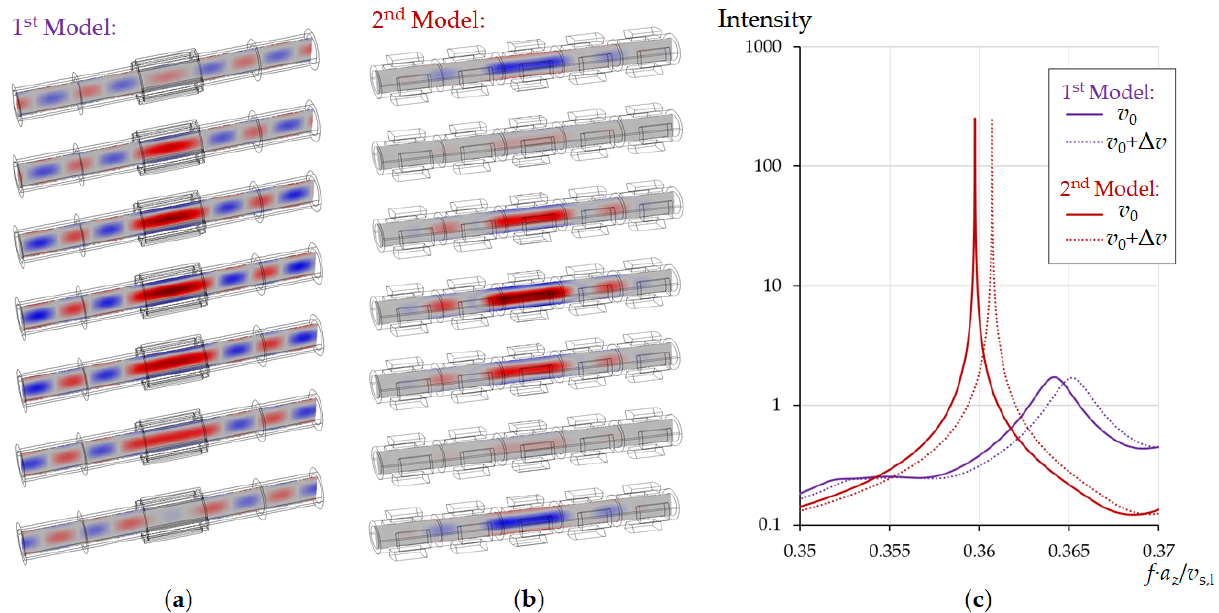
Figure 5. Snapshots of the pressure distribution in the pipe during one period of oscillation when excited in the center for the cases of a simple pipe ( a ) and a pipe surrounded by a periodic structure, ( b ) as well as comparison of the Q-factor of their resonances ( c ). The calculations were performed for water at a temperature of 20 °C, v 0 = 1481 m/s, ∆ v = 5 m/s. The inner diameter of pipe was d in = 353 μ m.